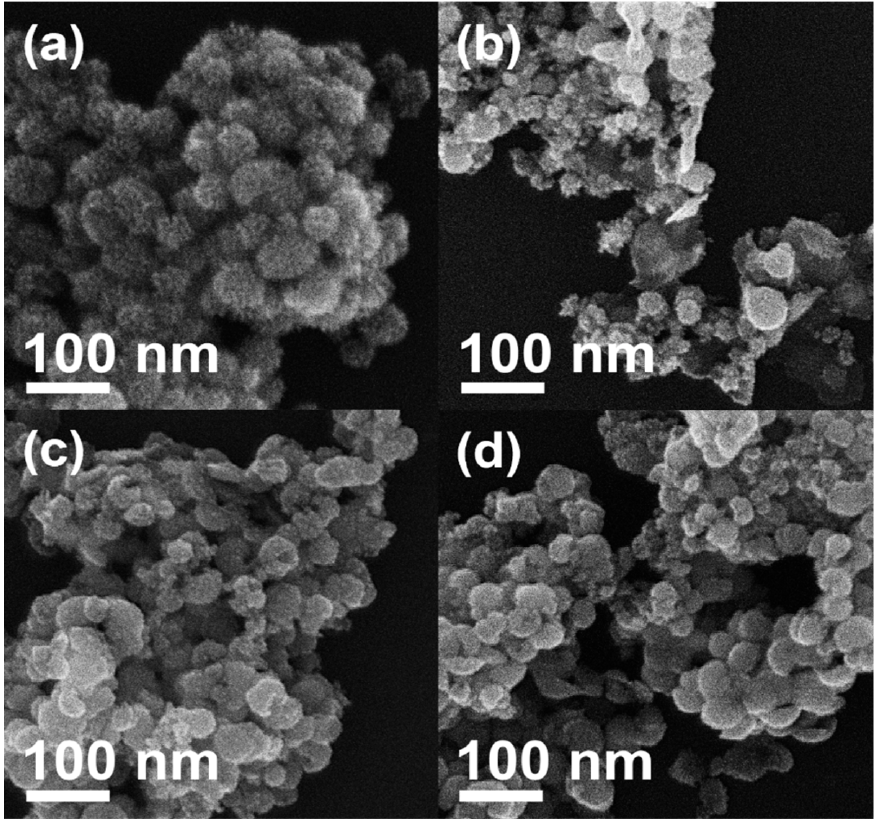
Figure 4. SEM images of Pd–Pt NDs prepared with controlled concentrations of CTAC with higher concentration of ( a ) 500 mM. Pd–Pt NDs prepared with lower concentration of CTAC than 10 mM with ( b ) 2.5 mM, ( c ) 5.0 mM and ( d ) 7.5 mM.